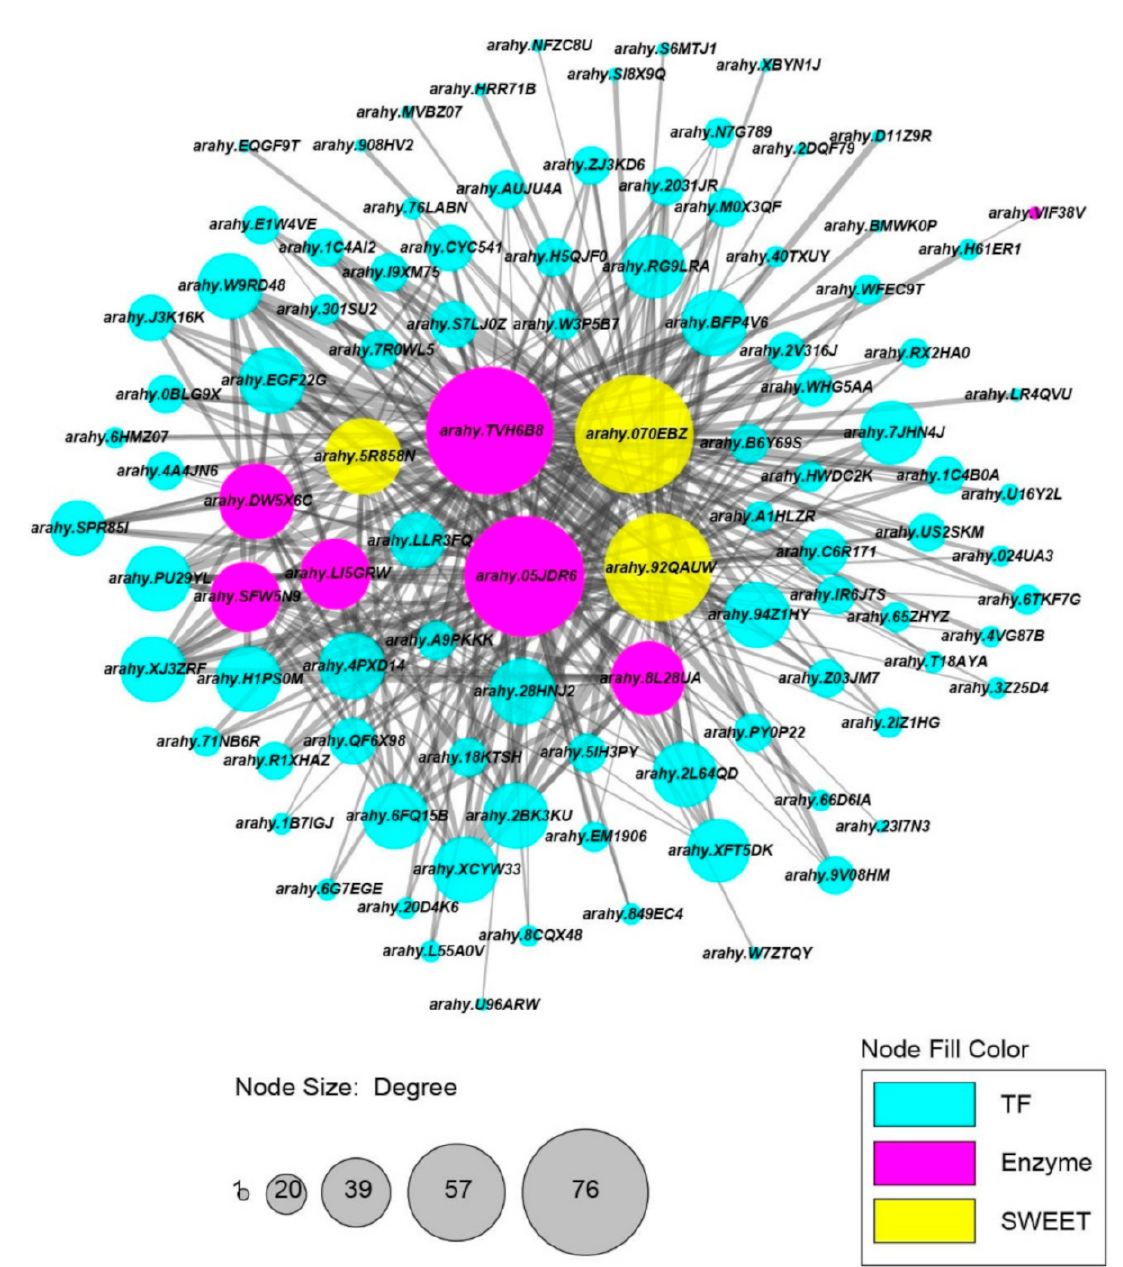
Figure 7. A gene co-expression network of 7 enzymes, 3 SWEETs genes, and 90 TFs. Each node represents a gene in the network and is labeled with the gene name. Fuchsia, yellow, and cyan nodes represent enzymes, SWEETs and TFs, respectively. Node size represents total connectivity. An edge indicates significant co-expression between two connected genes (weight value >